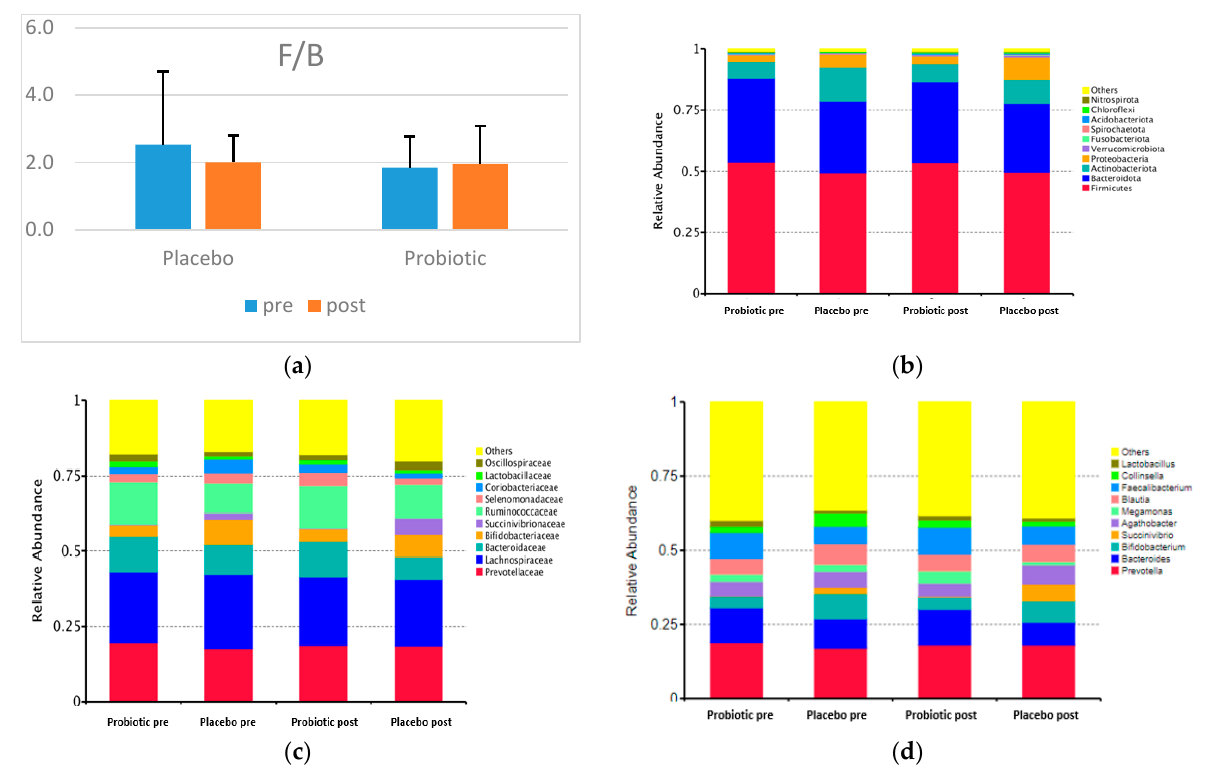
Figure 2. F/B and the top 10 relative abundances of GM composition between groups ( a ) F/B; ( b ) the top 10 relative abundances at the phylum level; ( c ) the top 10 relative abundances at the family level; ( d ) the top 10 relative abundances at the genus level.